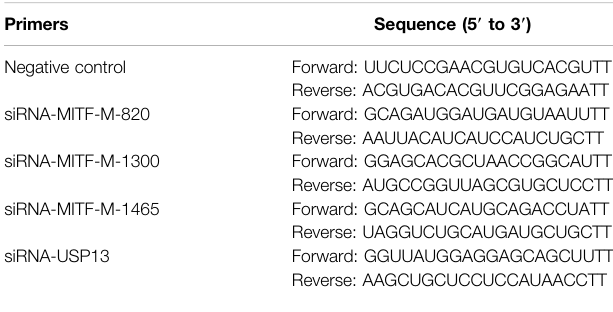
TABLE 2 | Primer sequences of siRNAs.